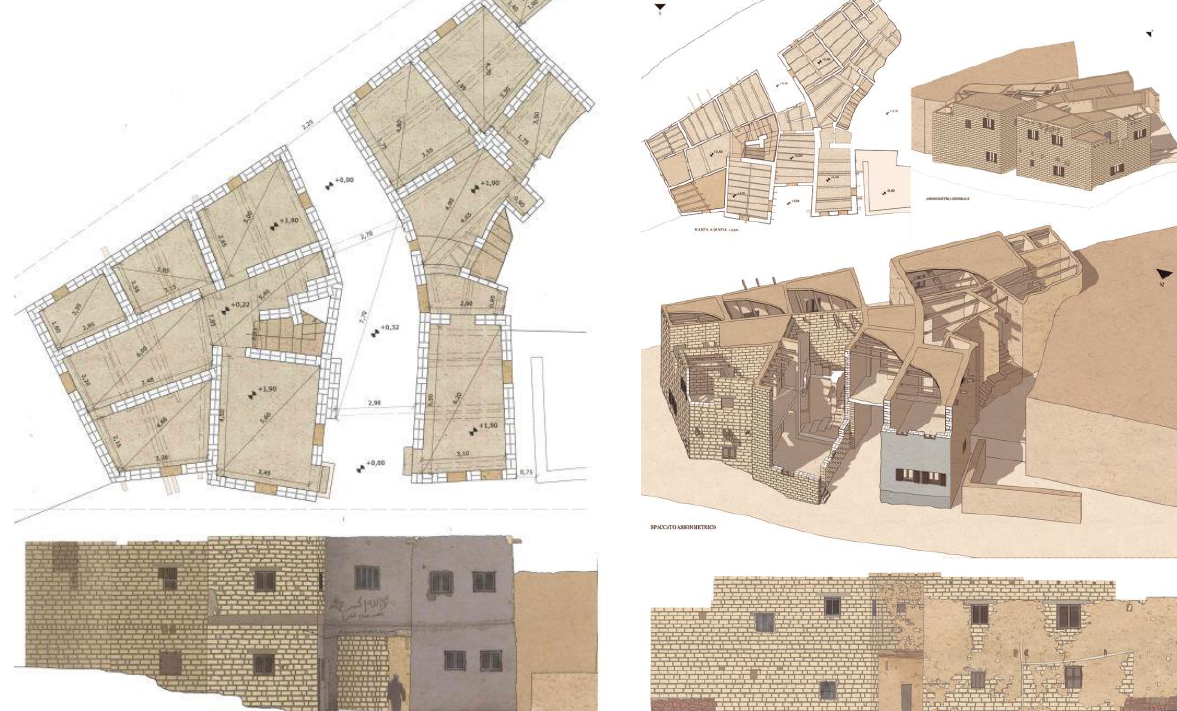
Figure 8. Typological studies on the Siwa Oasis (drawings courtesy of the following authors: Calvano S., Loconte P., Pizzolante S., Ricupero P. and Vitulli A.).